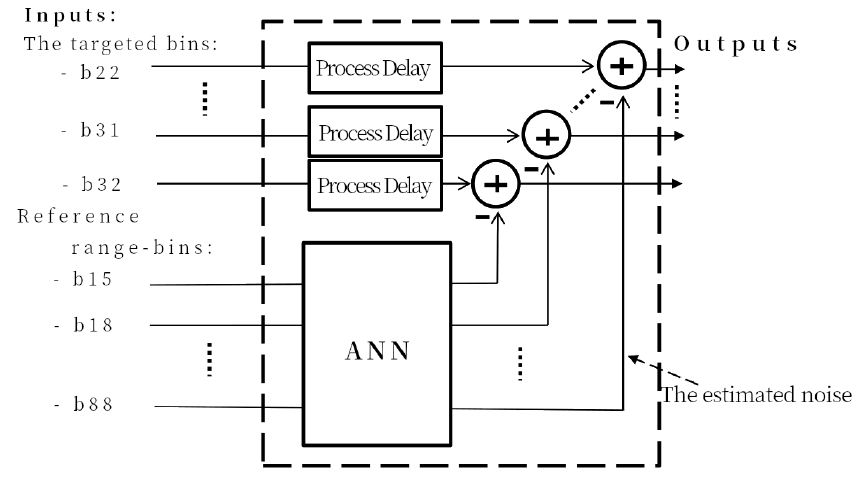
Figure 4. The block diagram for the RB-ANN interference (noise)